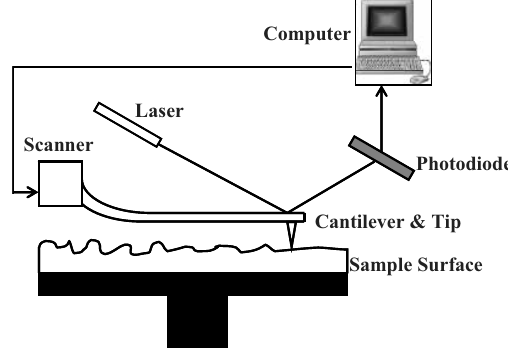
Fig. 2 A schematic representation of general principle of atomic force